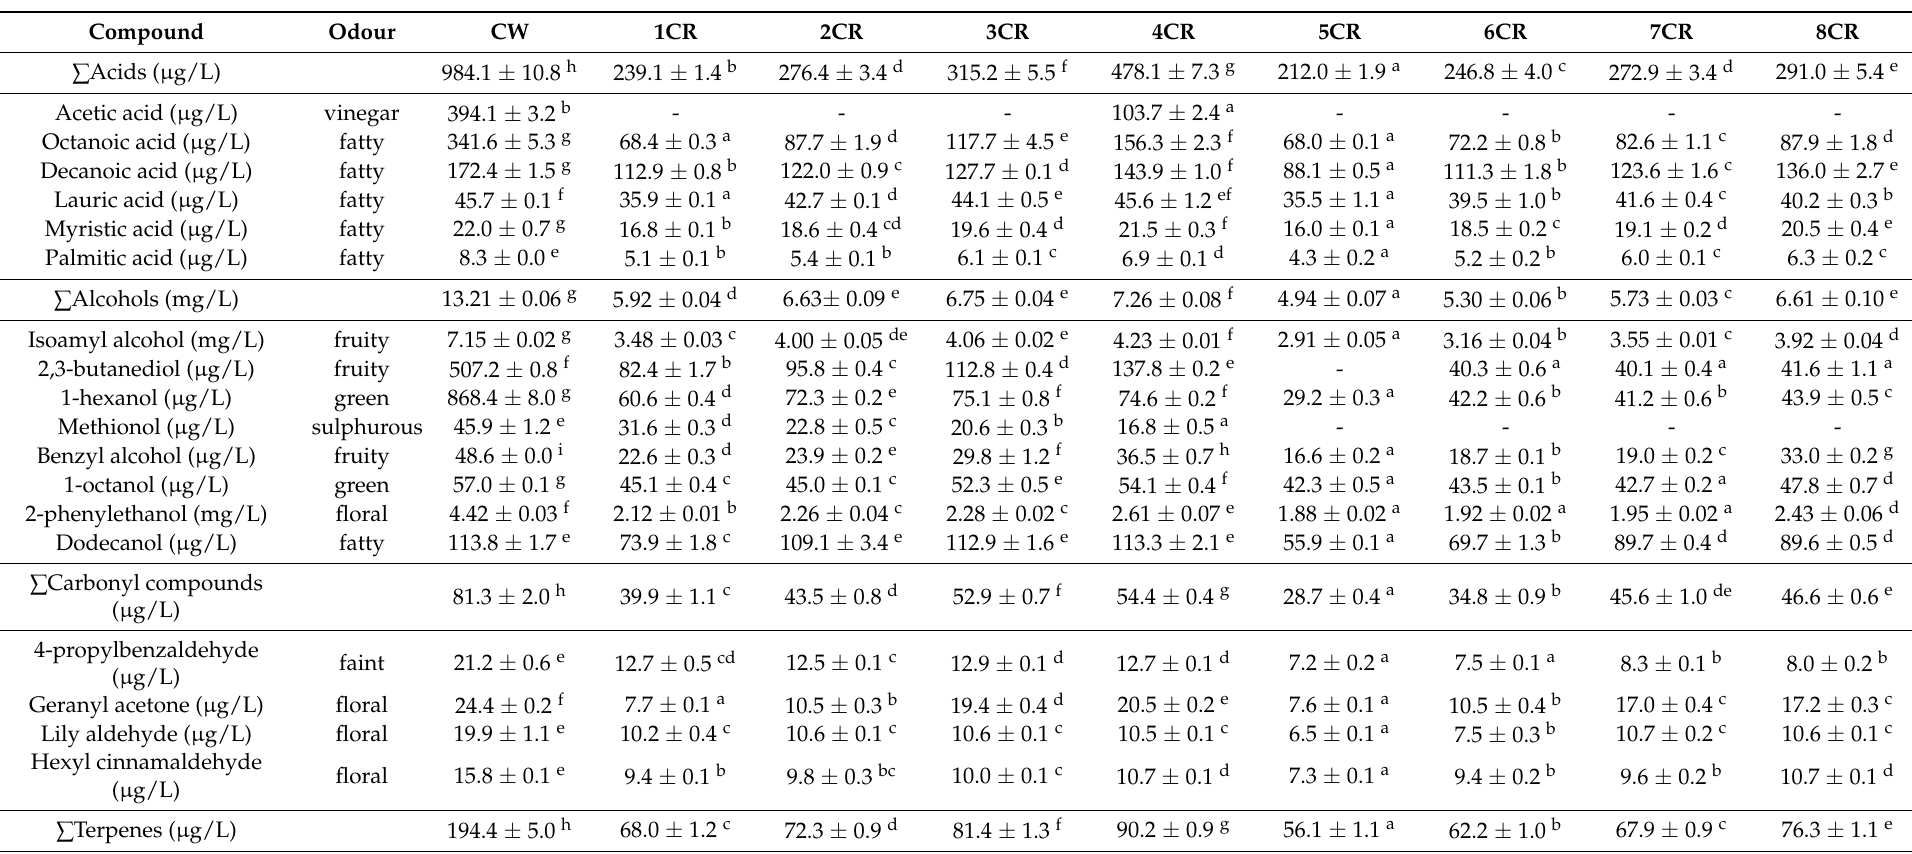
Table 1. Aroma compounds identified in the conventional Cabernet Sauvignon red wine and the RO retentates at 2.5, 3.5, 4.5 and 5.5 MPa, with cooling and without